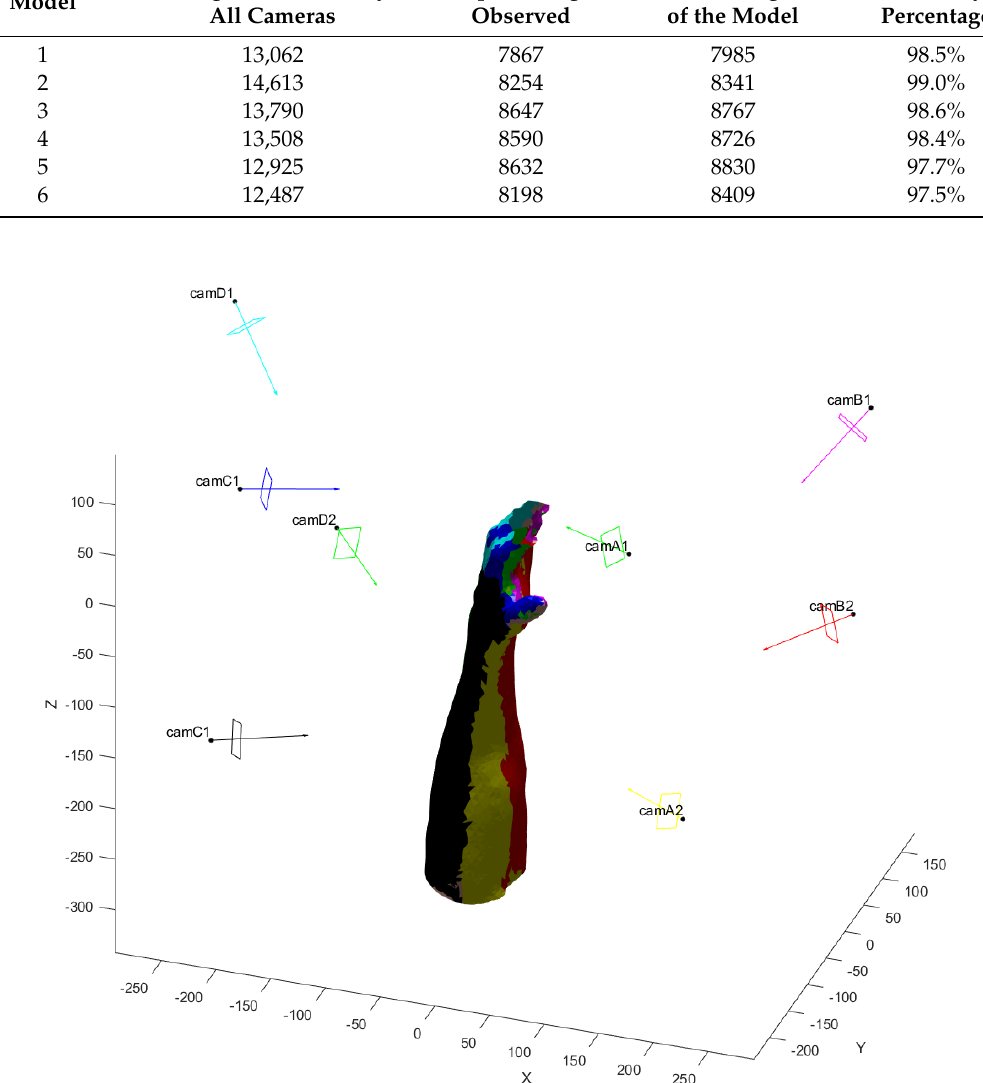
Figure 15. Final positions of the sensors with the visible color-coded regions on an arm model. Dimensions in (mm).